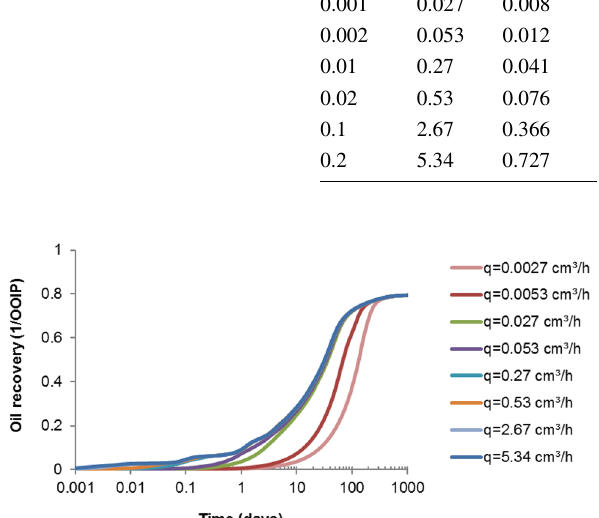
Fig. 9 Oil recovery versus time of surfactant flooding in a fractured matrix Table 7. The pressure drop between the injector and pro- ducer is increasing with the increase in injection rate. But because the matrix size is small, the pressure drop is only 0.727 atm even when the injection rate is 5.34 cm 3 /h.